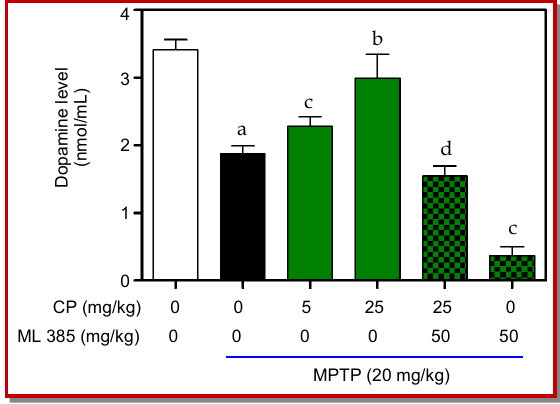
Figure 6: Nuclear factor E2-related factor 2 (Nrf2) inhibition neutralizes the protective effect of Cicadidae Periostracum (CP) following 1-methyl-4-phenyl-1,2,3,6-tetrahydropyridine (MPTP) treatment in vivo . The Nrf2 inhibitor, ML385 (50 mg/ kg), or saline were injected once daily intraperitoneally 30 min before CP treatment in the MPTP intoxication model. Dopa- mine levels in the striatum were measured using an enzyme- linked immunosorbent assay. a p<0.001 compared with the control group; b p<0.01 and c p<0.001 compared with the MPTP -treated group; d p<0.001 compared with the MPTP + CP